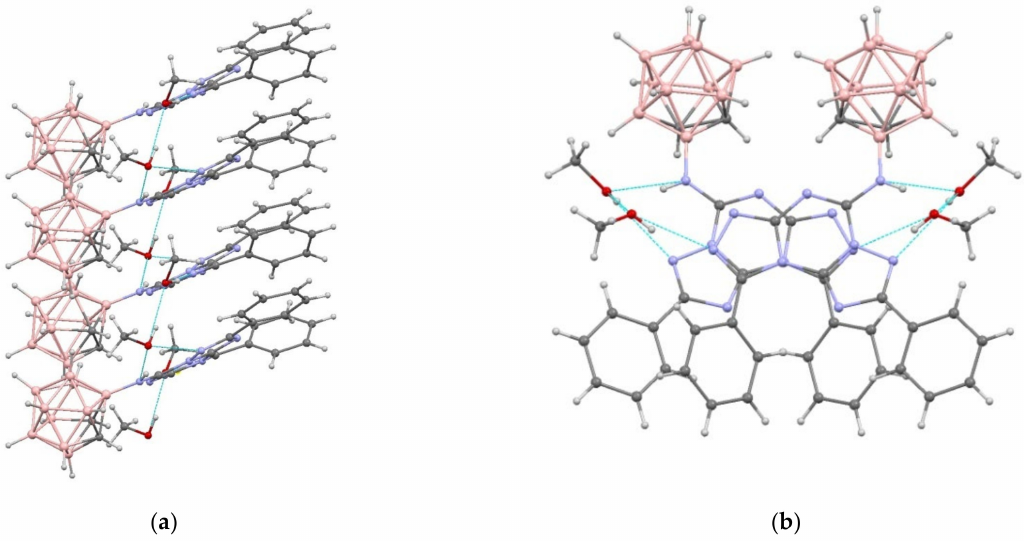
Figure 6. A fragment of an H-bonded stack in the crystal structure of 19 in two projections: ( a ) along the a axis of the crystal; and ( b ) along the c axis of the crystal.